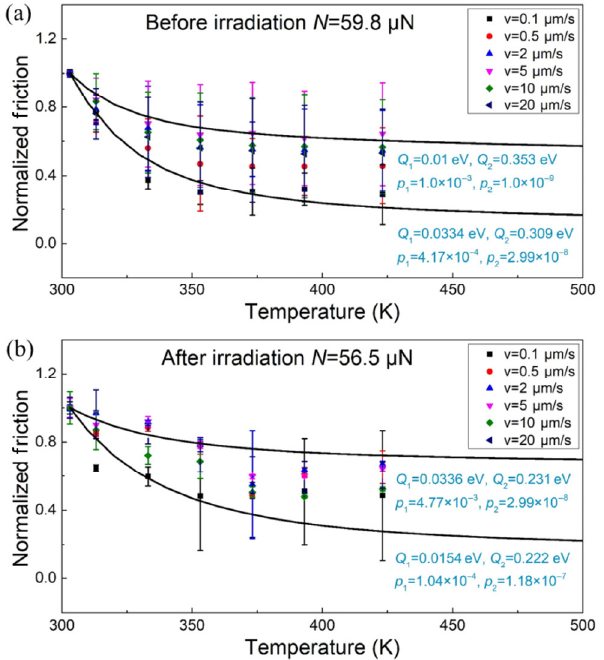
Fig. 5 Temperature dependence of the normalized friction forces (symbols) measured for different velocity for mesas before (a) and after (b) Argon plasma irradiation. The solid curves are fitting results according to Eq.